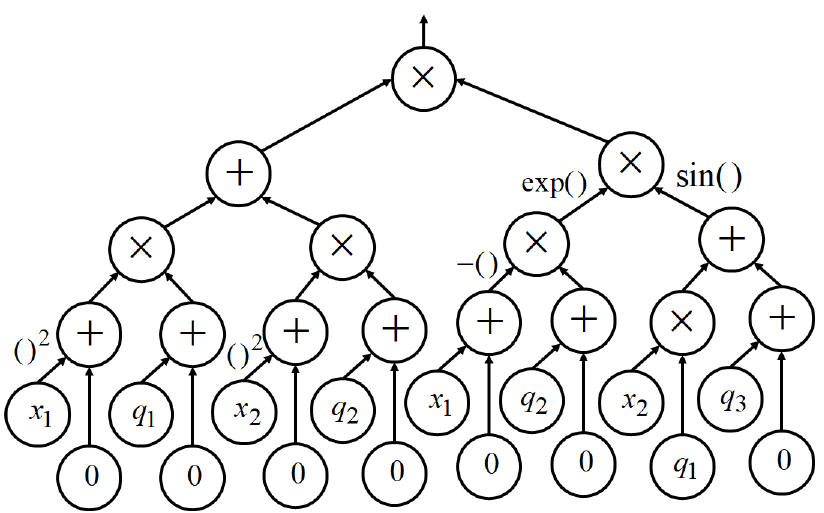
Figure 3. The BCGP graph of the function